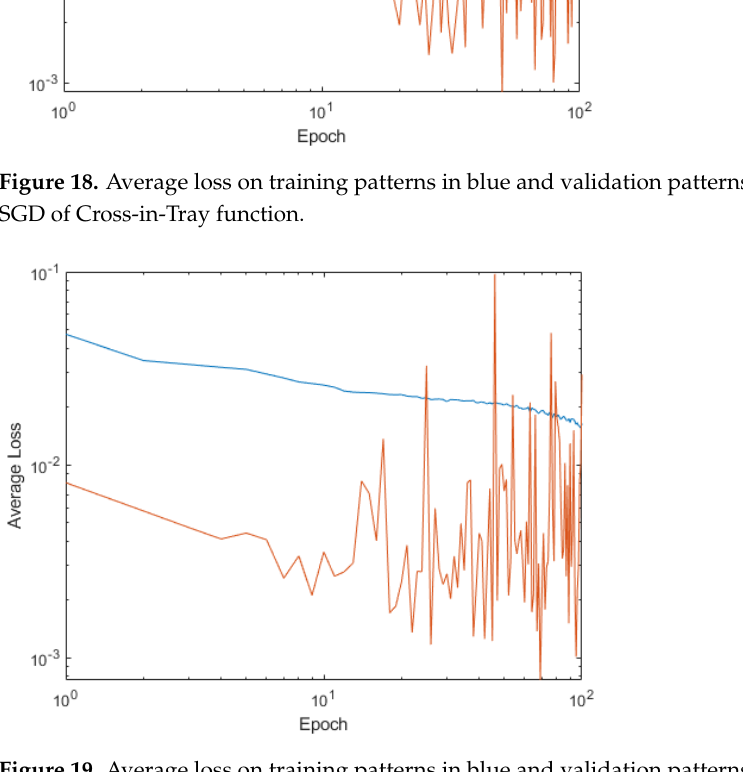
Figure 19. Average loss on training patterns in blue and validation patterns in orange for Dynamic alpha and Dynamic drop-out mixed together SGD of Cross-in-Tray.